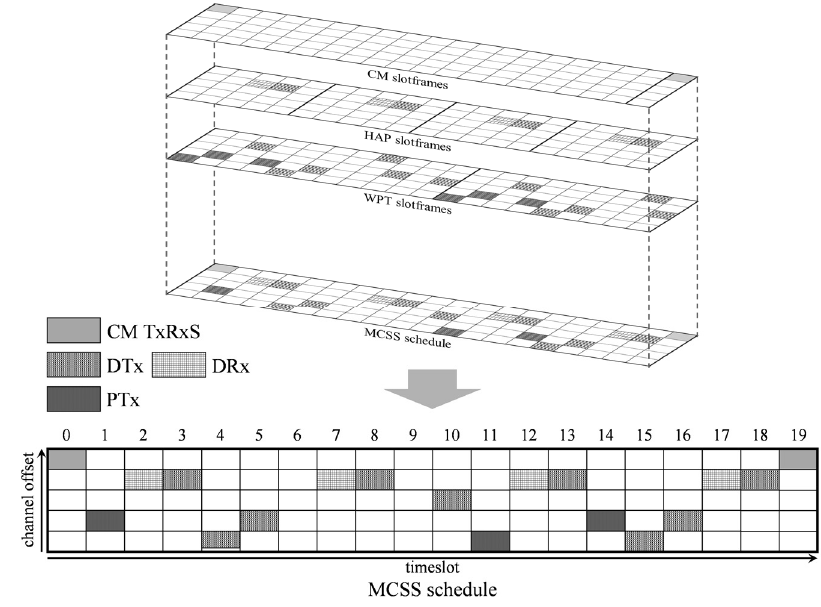
Figure 4. Example of an MCSS schedule.